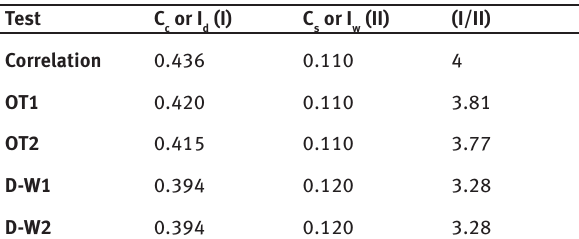
Table 8: Comparison of compressibility parameters of drying- wetting and oedometric